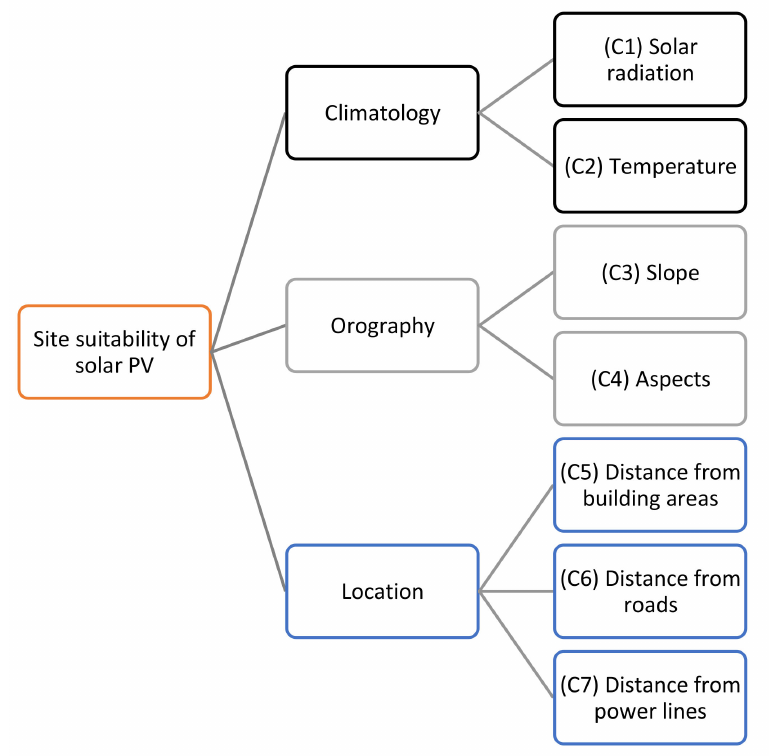
Figure 6. Comparison matrix of the adopted decision